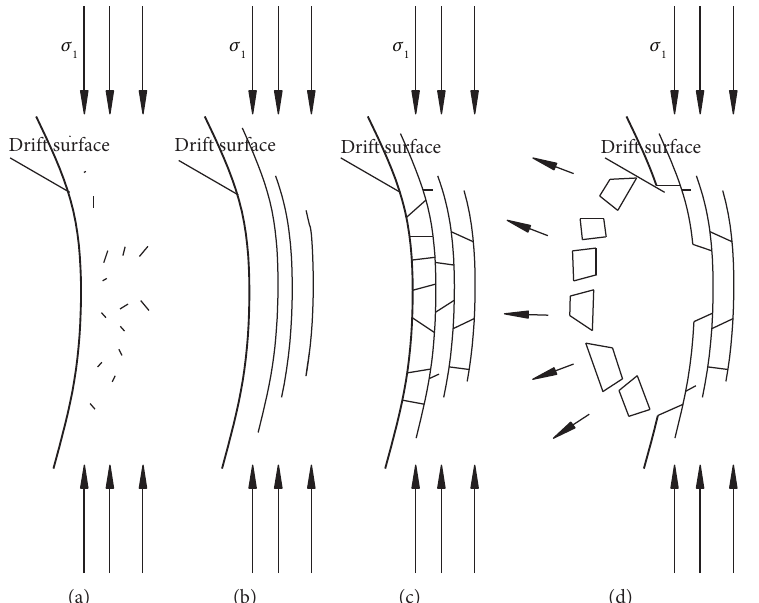
Figure 1: The evolving process of strain rockburst in a drift. (a) Tensile crack propagation. (b) Spalling into plates. (c) Shearing into blocks. (d) Ejection of